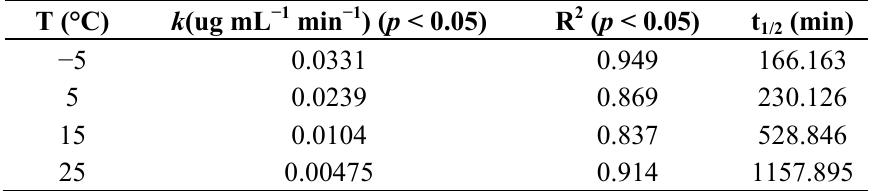
Table 2. Degradation Kinetics Parameters k (rate constant), R 2 (determination coefficients), t (half-life periods) of caffeic acid under ultrasound 1/2